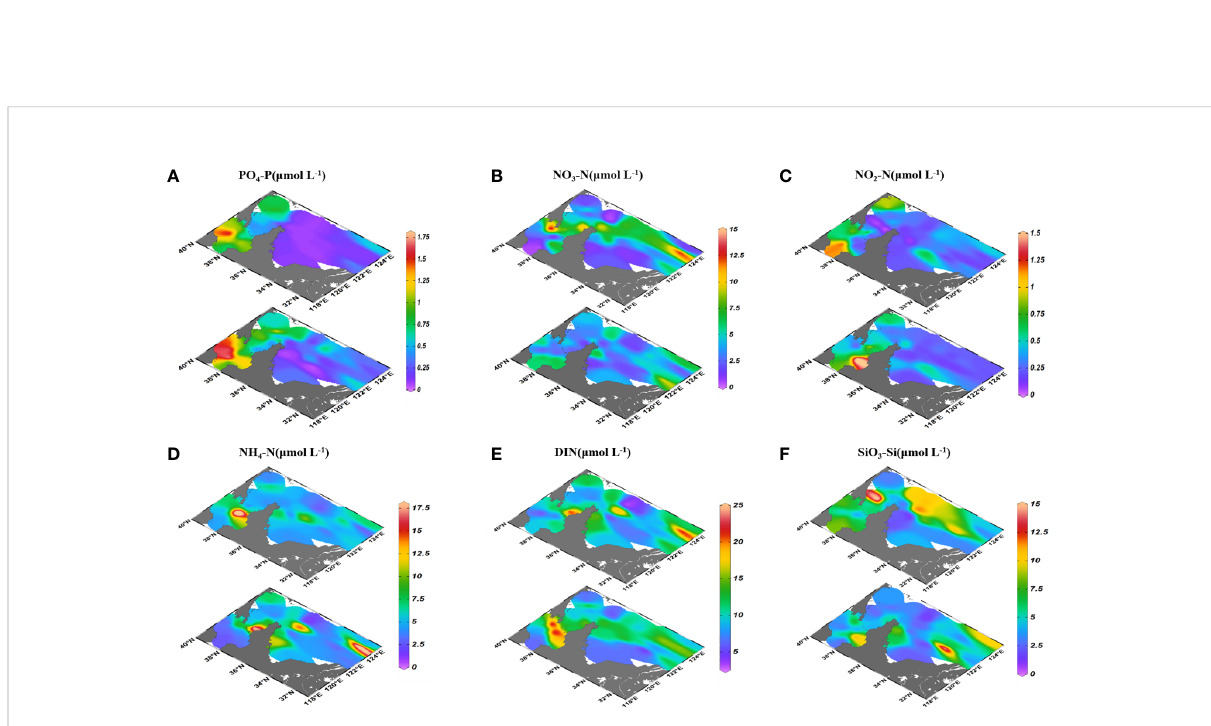
FIGURE 4 Distributions of PO 4 -P (A) , NO 3 -N (B) , NO 2 -N (C) , NH 4 -N (D) , DIN (E) and SiO 3 -Si (F) in surface and bottom seawaters of the BS and YS.